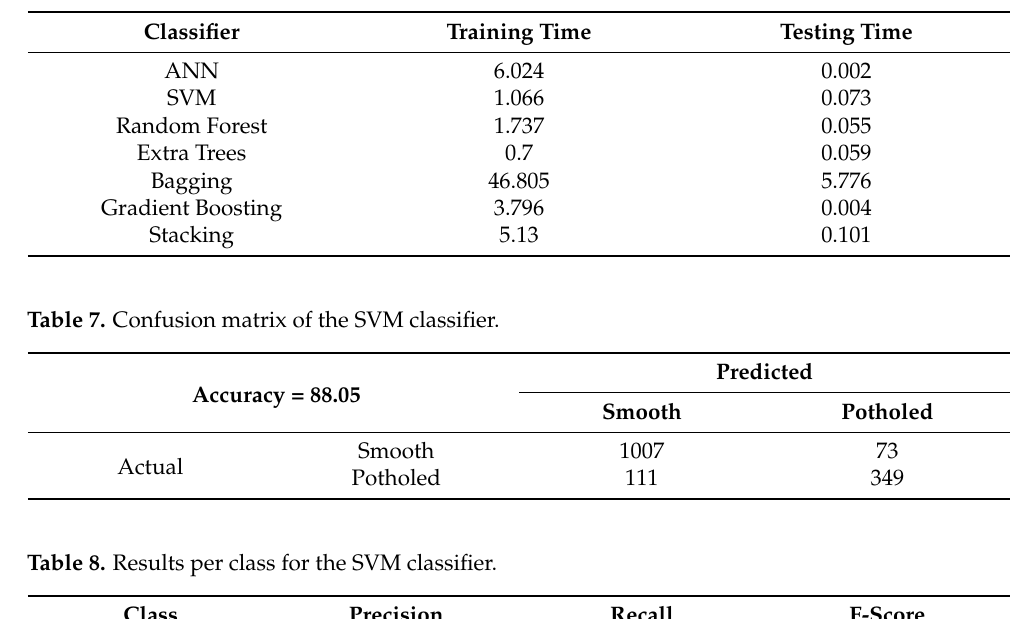
Table 6. Execution times (training and testing) for all classifiers.